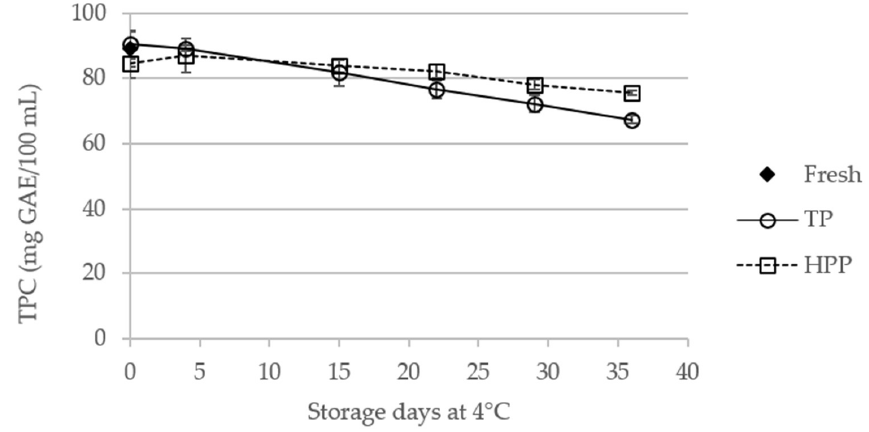
Figure 1. Total phenolic content (TPC) of fresh and thermal pasteurized (TP) and high-pressure processed (HPP) orange juices during storage at 4 °C.